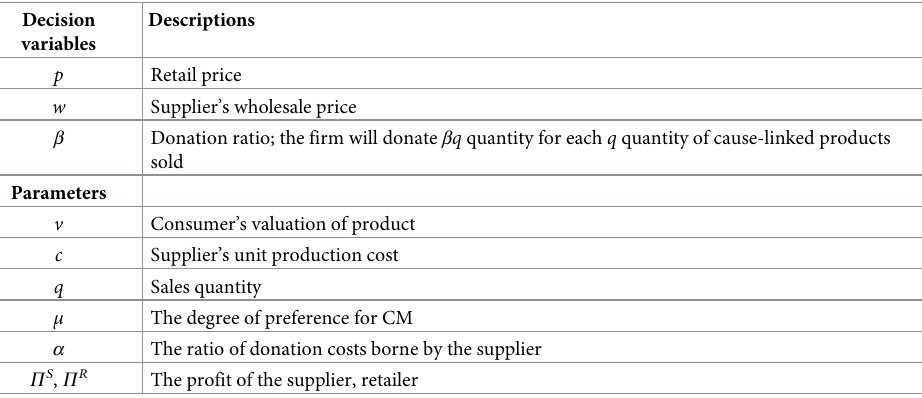
Table 1. Notations of parameters and